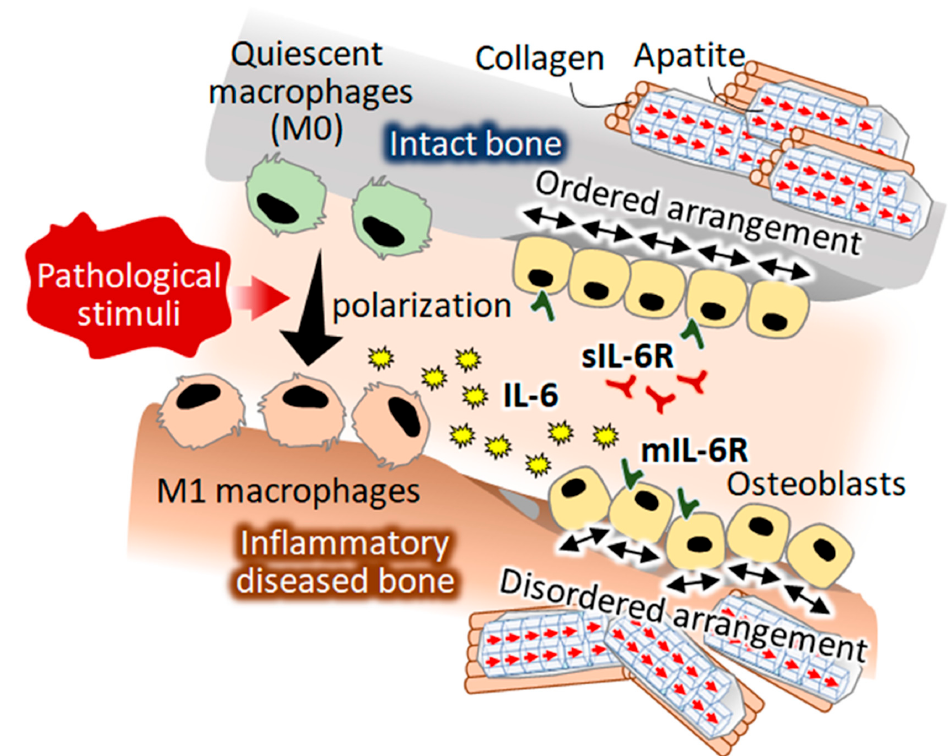
Figure 7. A hypothesized mechanism of pathological stimuli-induced disorganization of bone tissue. A novel function of M1-polarized macrophages in controlling osteoblast arrangement